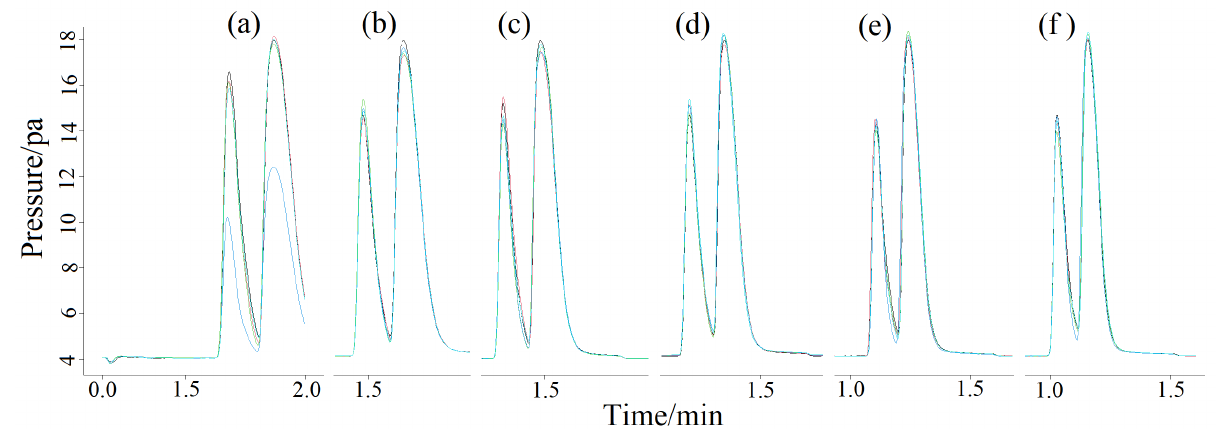
Figure 3. Ghost peaks of methane were measured at different flow rates of capillary column ( a – f ) (5 repetitions per sample, 30 mL min − 1 of total carrier gas flow) in manual splitless mode. The make- up gas flow rates in the capillary column were 24 ( a ), 23 ( b ), 22 ( c ), 21 ( d ), 20 ( e ) and 19 mL min − 1 ( f ), respectively, at a total flow rate of 30 mL min − 1 .